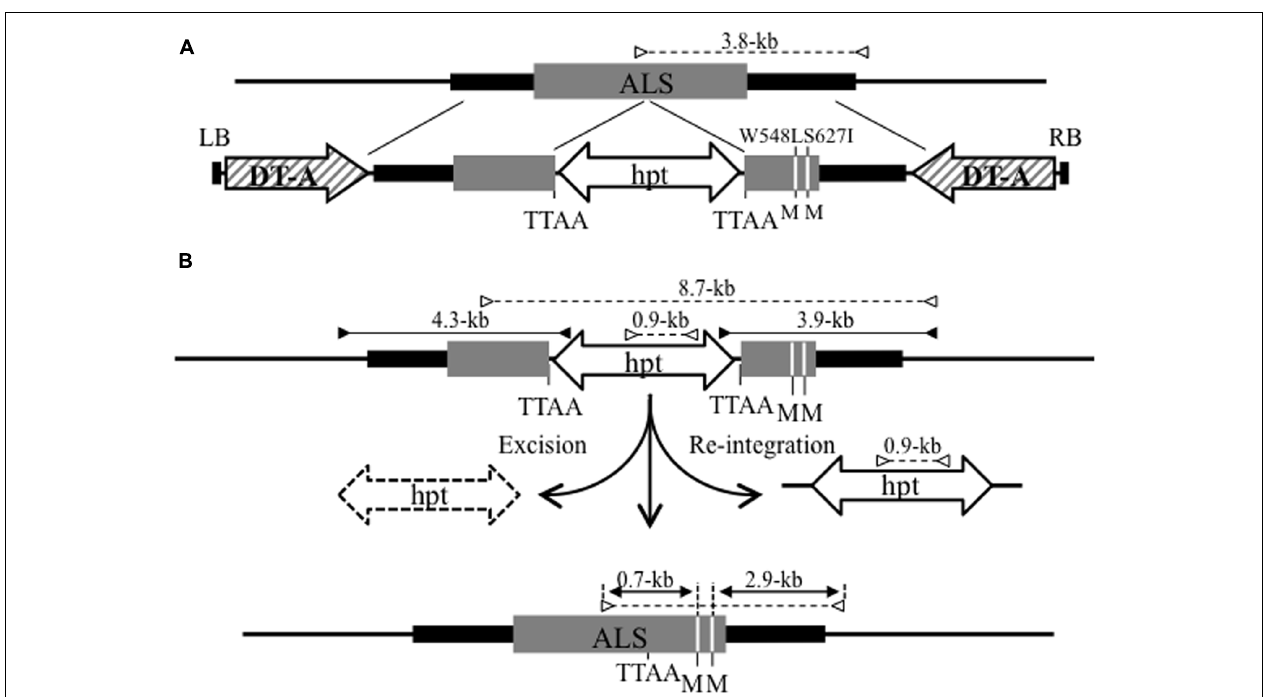
restriction sites (M). LB, left border; RB, right border. (B) Strategy for precise marker excision from the GT locus using piggyBac transposon.The top line reveals the structure of the modified ALS locus resulting from HR between the GT vector and wild-type locus.The bottom line represents the ALS locus modified by GT and subsequent precise marker excision via piggyBac transposition.The primer sets used for PCR that identify transgenic calli in which a GT event occurred at the ALS locus are shown as black arrows.White arrows indicate the primer sets used for CAPS analysis to evaluate the frequency of marker excision via piggyBac transposition.The numbers on each arrow reveal the length of the PCR